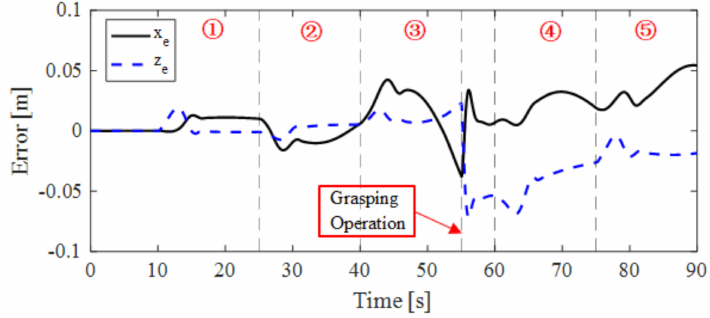
Figure 11. The position tracking error of end effector with vehicle position